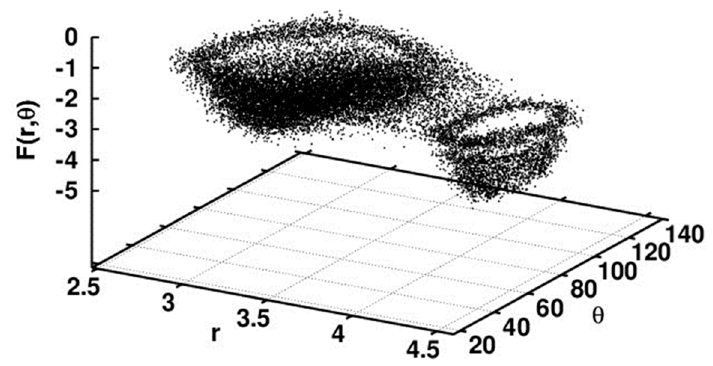
Figure 13. F(r, θ ) for N-H···F1-C H-bond occurring in molecule 7 .